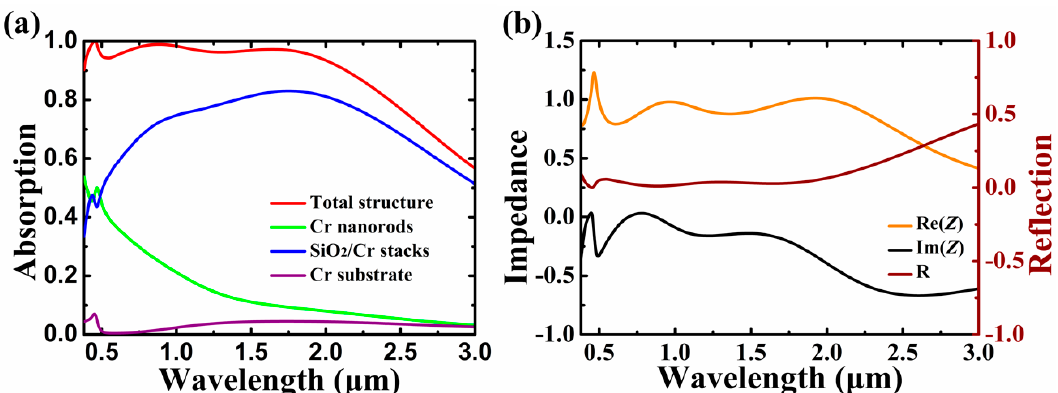
Figure 2. ( a ) Absorption of the Cr-based MA and its absorption distributions in different parts of the structure. ( b ) Impedance and reflection curves of the Cr-based MA. Other parameters are kept the same as Figure 1a.